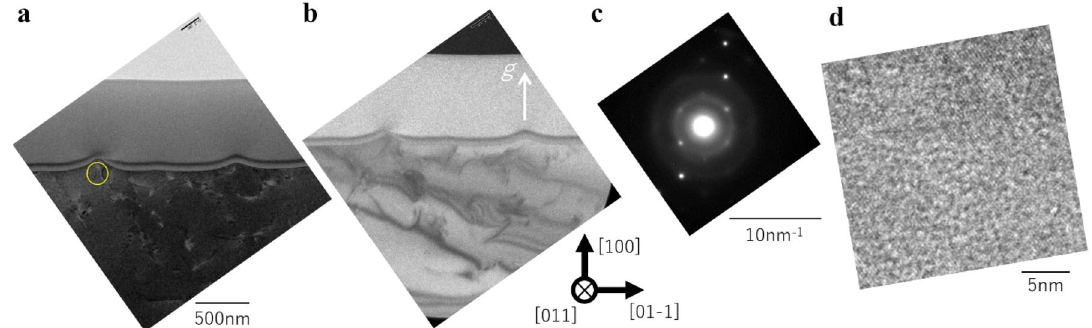
Figure 4. TEM images of the LIPSS induced by MIR-FEL. ( a ) Bright-field TEM image, ( b ) dark-field image, ( c ) diffraction pattern and ( d ) high-resolution image of the marled area in figure ( a